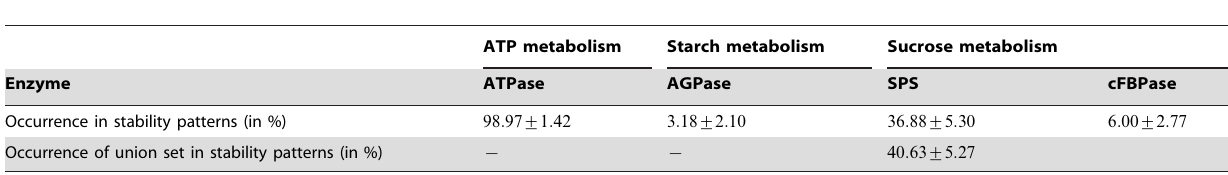
Table 4. Enzyme occurrences in the derived patterns (ATP, starch and sucrose metabolism).